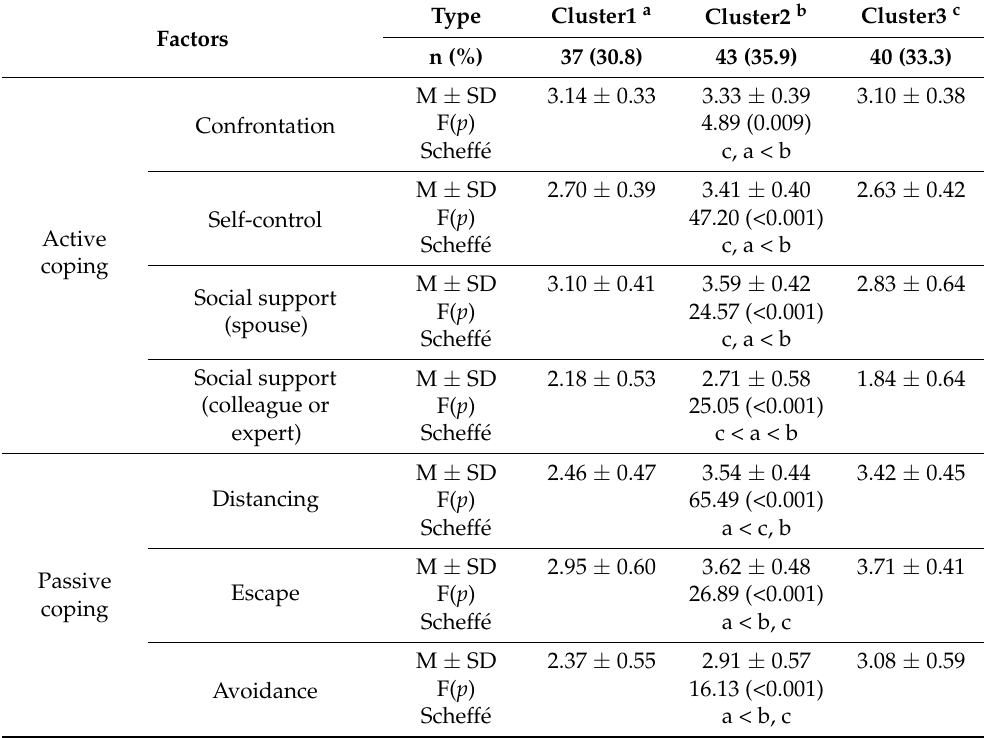
Table 3. Infertility stress-coping type ( N =